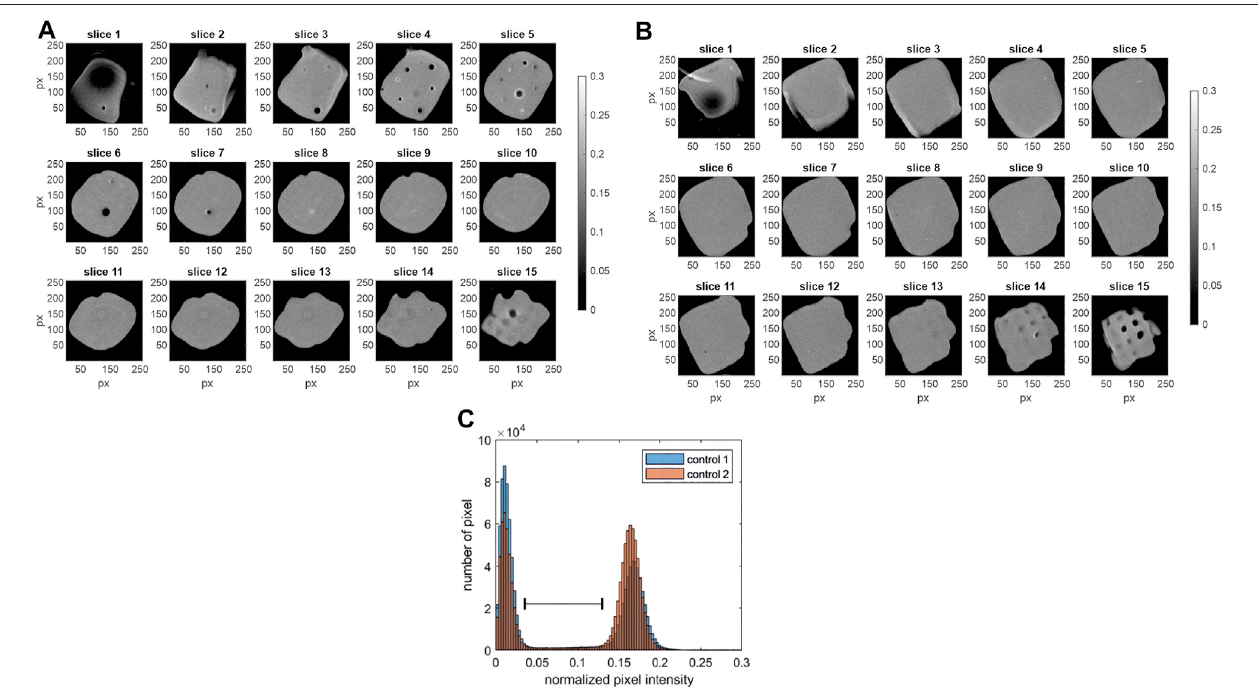
FIGURE2 | MRI data ofthe control samples. Shown arethe grey scale images ofthe 15 axial slices (z-stack) with slice 1 asbottom and slice 15 astop slice (256 × 256 px). (A) control 1, fi eld of view 12 mm 2 × 12 mm 2 (B) control 2, fi eld of view 12 mm 2 × 12 mm 2 . (C) Additionally, the histogram of the normalized pixel intensity (including all 15 slices of each MRI data set) is shown for both control samples. Low normalized pixel intensity < 0.05 characterizes dark pixels in the images (A,B) . High pixel intensities representing the hydrogel areas (0.12 < I < 0.23) are displayed in bright colors. The black spacer visualizes the expected range of pixel intensity, where peaks of the samples containing cells with T 2 contrast agents are